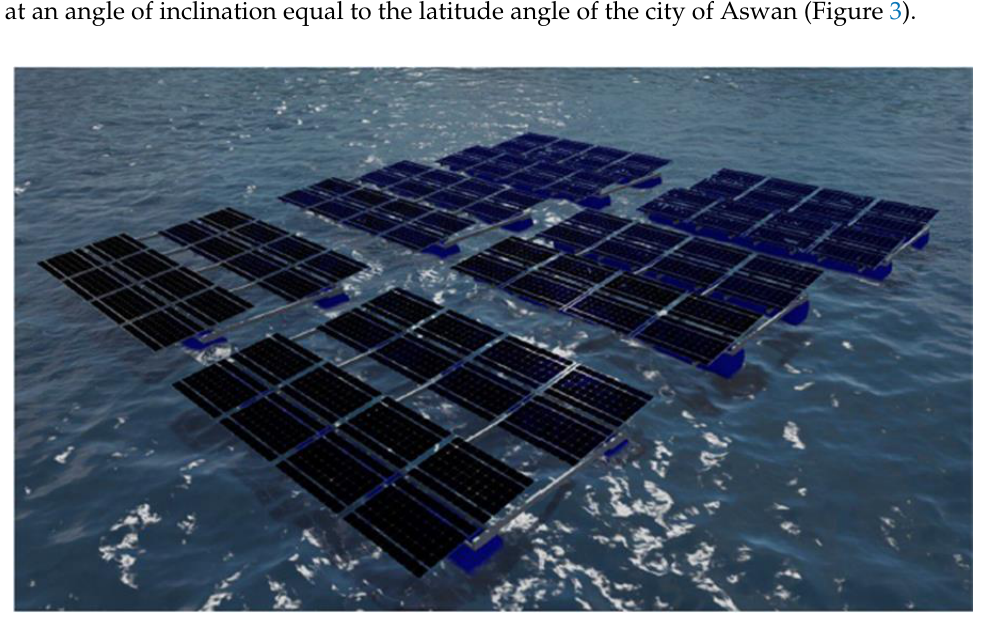
Figure 3. Photo of floating photovoltaic (FPV) panels. The floating platform consisted of several photovoltaic panels of the type (AE HM400M6-72) 400 W monocrystalline modules. The number of FPV panels utilized in this study depended on the area proposed to be covered. These FPV panels were connected in series and placed in multiple rows, with each series connected to the MPPT input of the